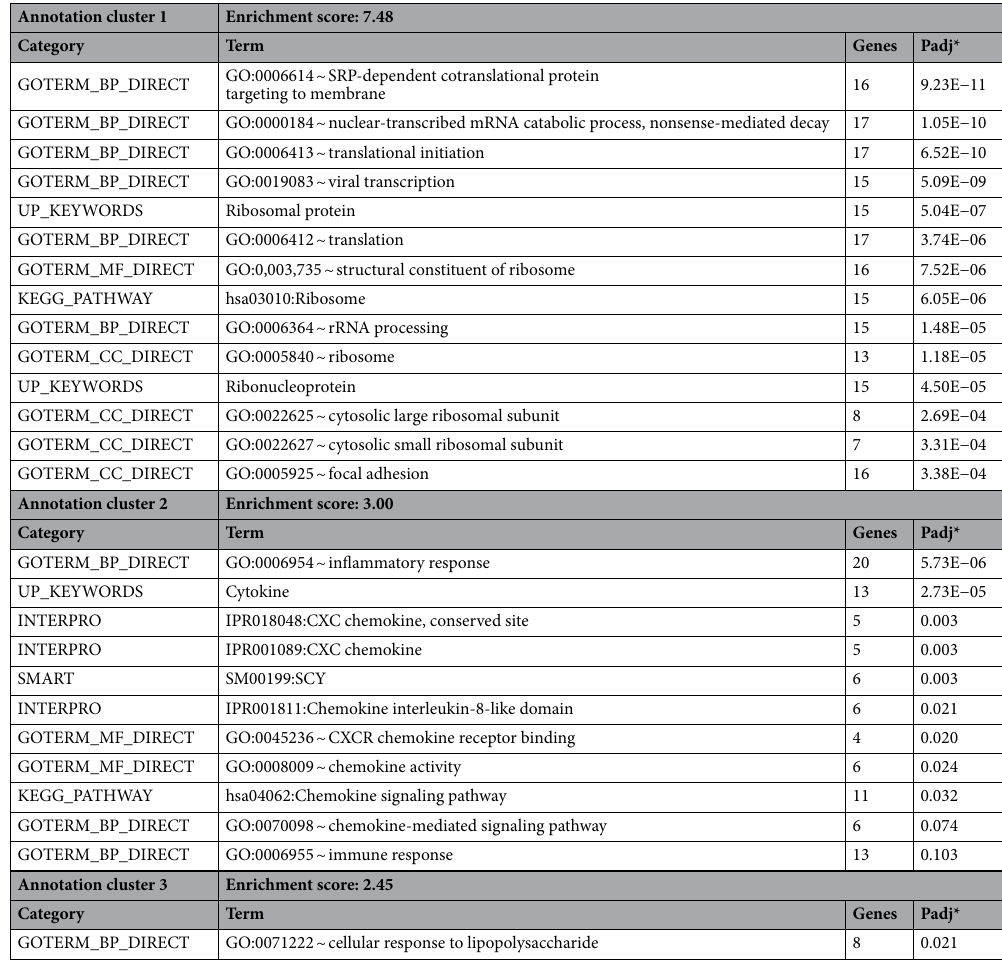
Table 3. Enriched terms in the gene list differentially regulated by e-cig smoke solution. *Padj: adjusted p-values for multiple comparisons by the Benjamini Hochberg